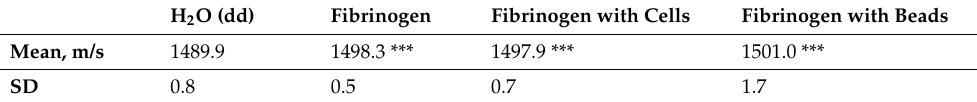
H 2 O (dd) stands for double-distilled water. *** represents p values less than 0.0001 for three independent fibrinogen preparations.